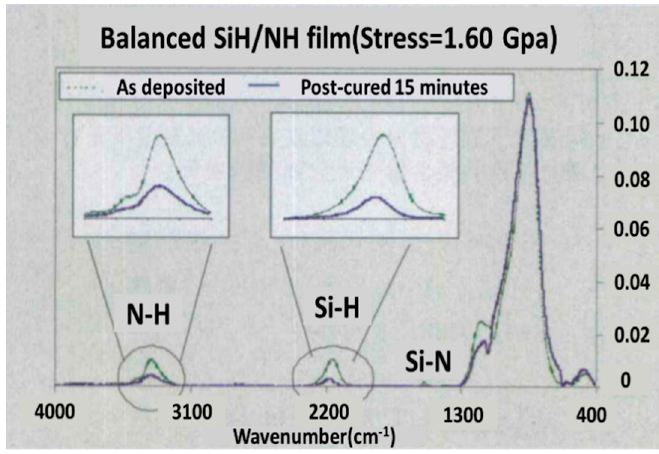
Figure 29. A spectrum shows the improvement of tensile stress using ultraviolet thermal process (UVTP) method